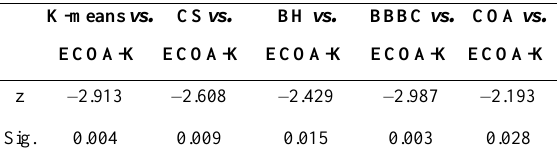
Table 7. Results obtained by statistical analysis of algorithms based on CV criteria on CMC dataset. K-means vs.